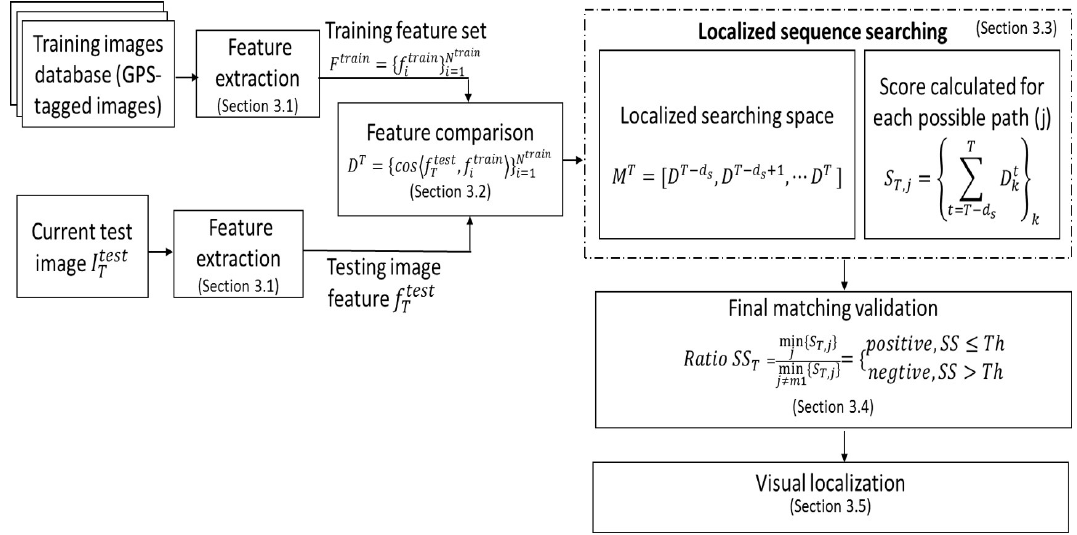
Figure 1. A detailed block diagram of the proposed visual localization method: Feature extraction uses a pretrained network, feature comparison uses the cosine distance, and localized sequence searching is conducted based on the potential